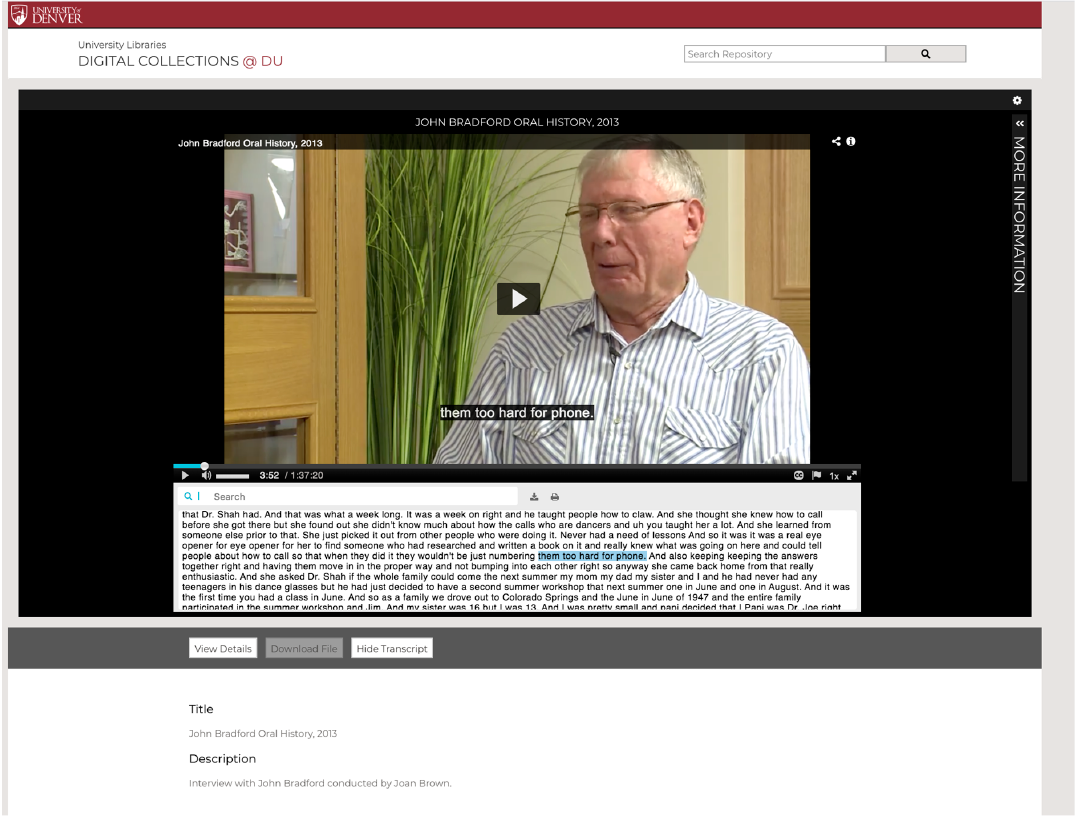
Figure A4. Video viewer (Kaltura embedded in UniversalViewer).